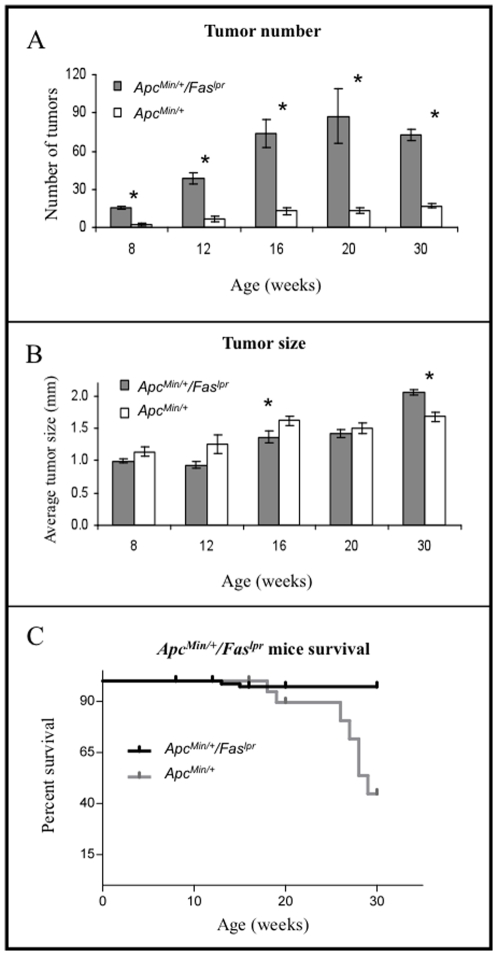
Tumor burden and survival.(A) Intestinal tumor number, (B) tumor size, and (C) survival rate of ApcMin/+ and ApcMin/+/Faslpr mice. Error bars in panels (A) and (B) represent standard error of the mean.